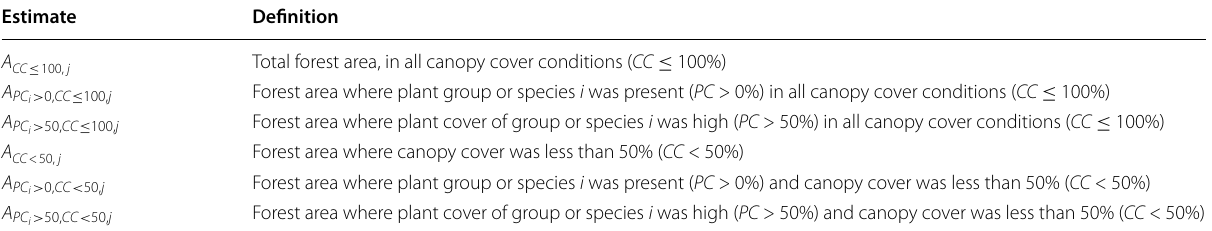
Table 1 Area estimates used to calculate the various NFI indicators; PC canopy cover, and A the forest area (ha), in region j